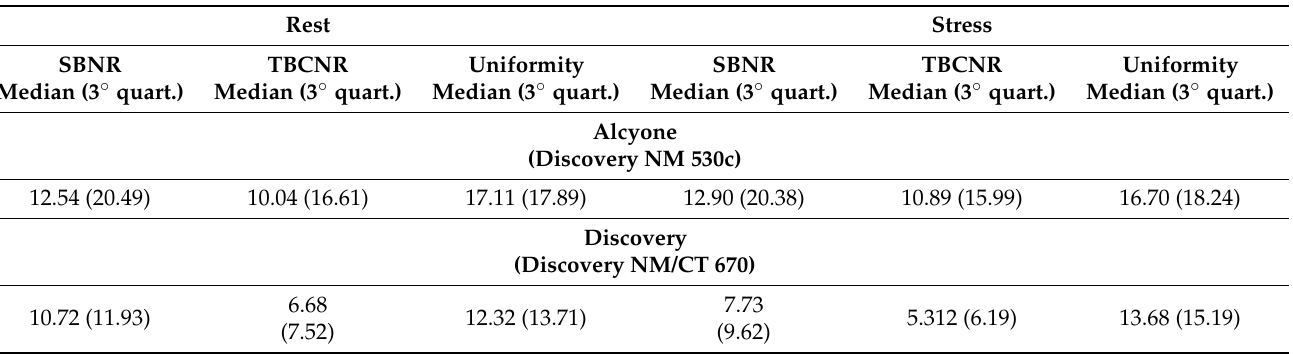
Table 8. SBNR, TBCNR, and uniformity indexes from patients.